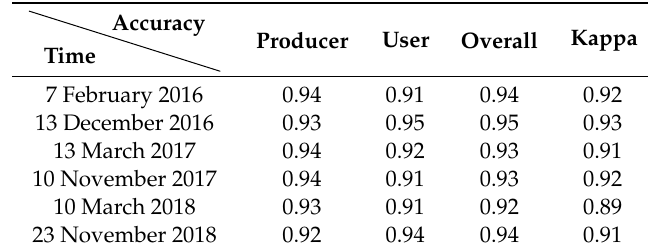
Table 4. Producer’s and user’s accuracies of S. alterniflora , and overall accuracies and Kappa coe ffi cients of classification results.